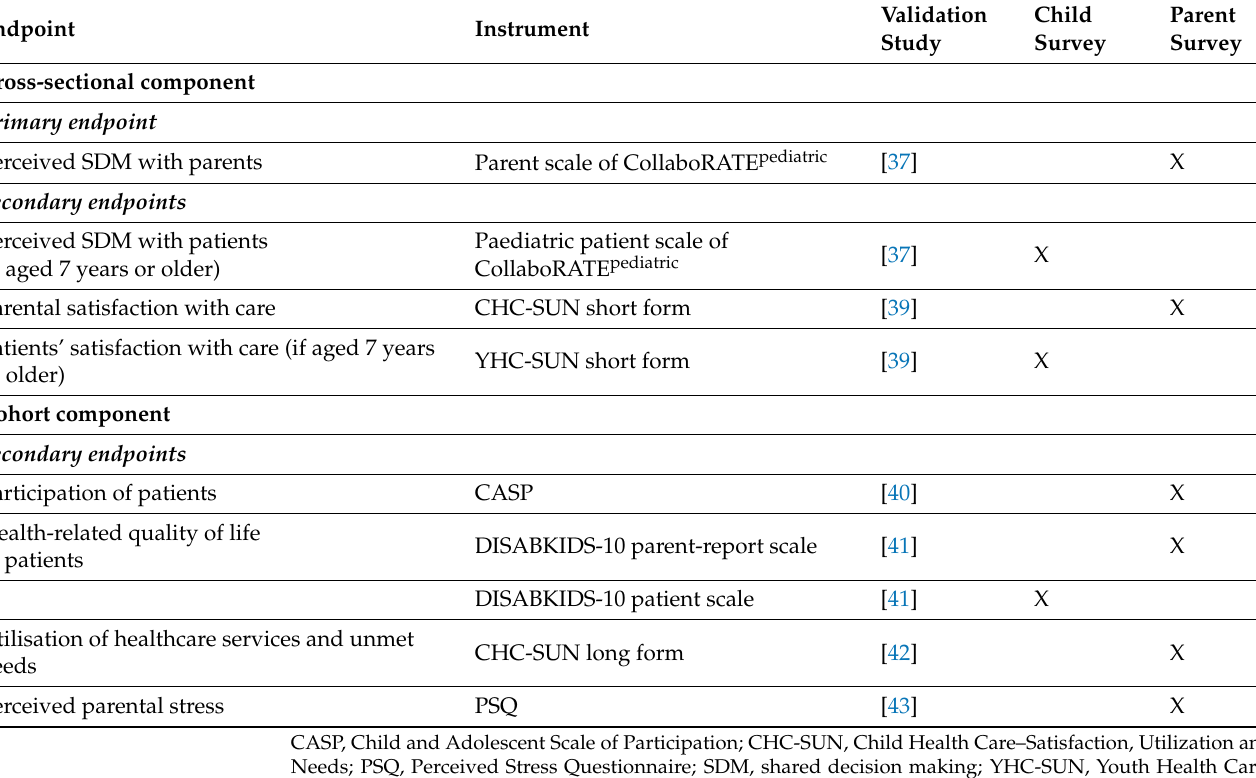
Table 2. Primary and secondary endpoints of the effectiveness evaluation and their